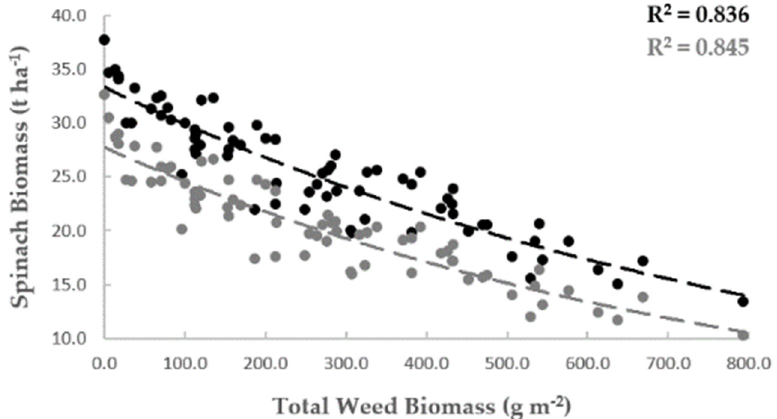
Figure 2. Black: the relationship between total spinach biomass (t ha − 1 ) and total weed biomass (g m − 2 ). Grey: the relationship between commercial spinach biomass (t ha − 1 ) and total weed biomass (g m − 2 ).